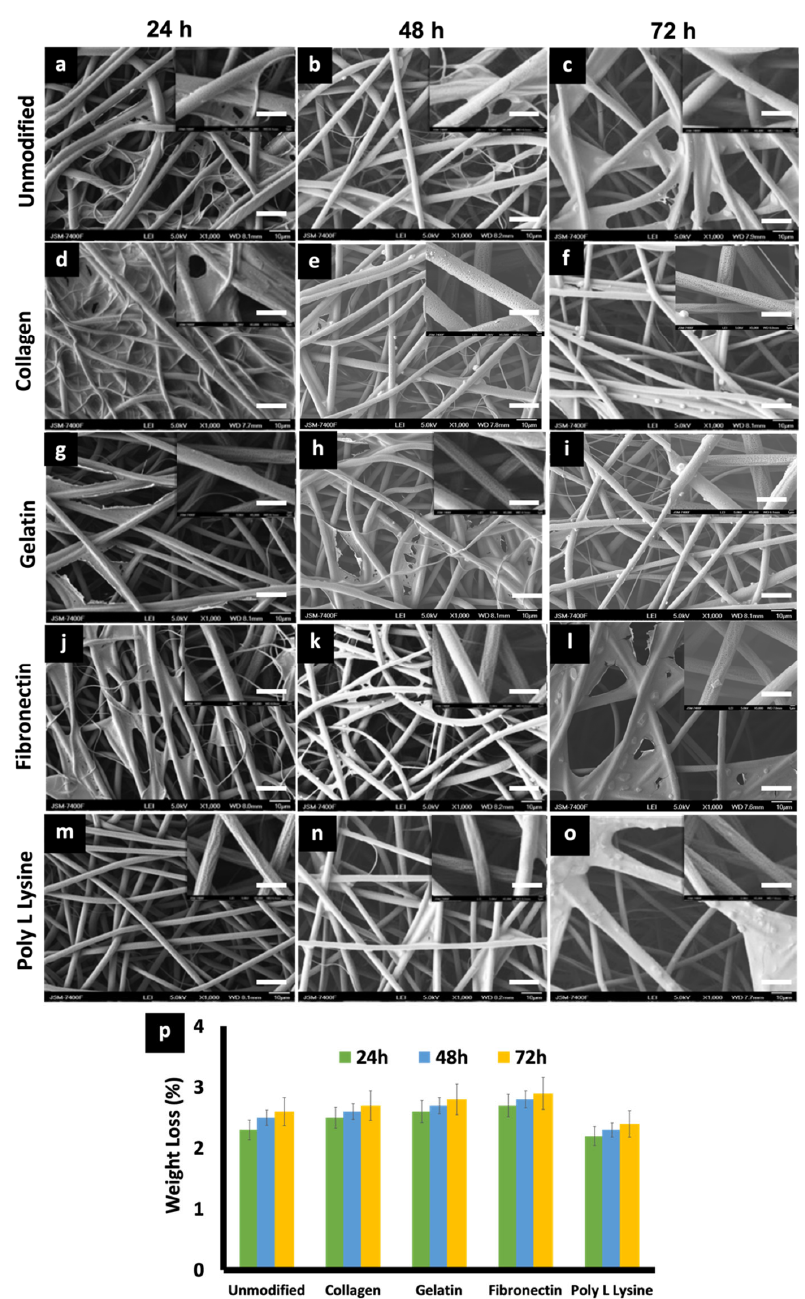
Figure 6. ( a – o ) SEM micrographs depicting the morphological features of ( a ) 24 h, ( b ) 48 h, ( c ) 72 h, PLLA unmodified electrospun sca ff old, ( d ) 24 h, ( e ) 48 h, ( f ) 72 h PLLA collagen, ( g ) 24 h, ( h ) 48 h, ( i ) 72 h] PLLA gelatin, ( j ) 24 h, ( k ) 48 h, ( l ) 72 h, PLLA fibronectin ( m ) 24 h, ( n ) 48 h, ( o ) 72 h and PLLA poly L lysine sca ff olds after being immersed in Cardiac fibroblast media for 24, 48, 72 h at 37 ◦ C. (scale bar = 10 µ m). Insets are magnified versions of the corresponding surface (scale bar = 1 µ m). serum protein adhesion, in the form of films can be observed in the samples. ( p ) Weight loss percentage of unmodified and protein modified sca ff olds after in vitro degradation studies in media for 3 days.